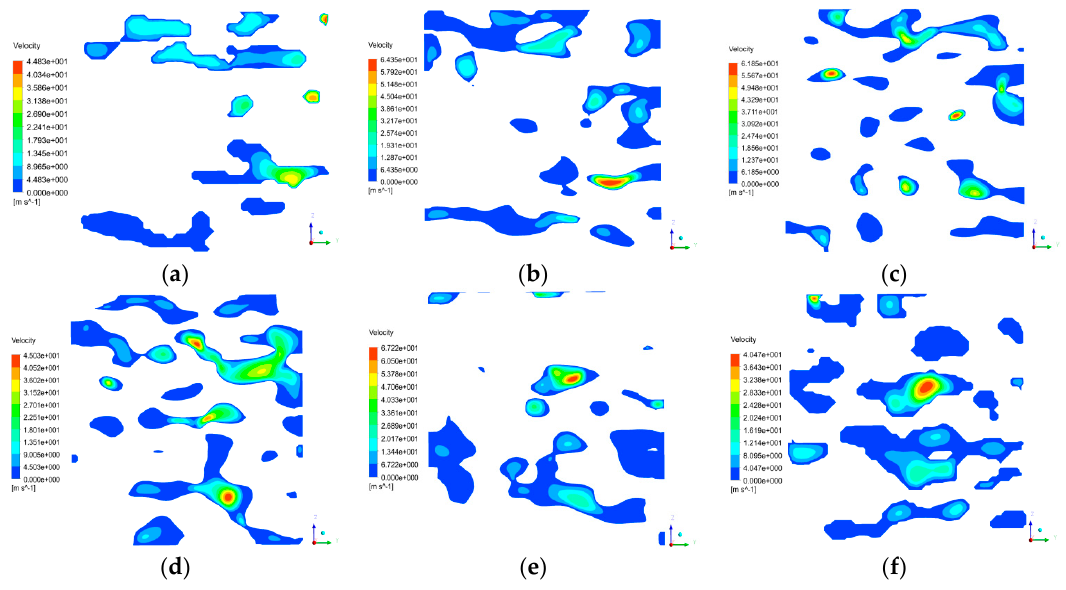
Figure 12. Water seepage velocity distribution of different sections of the single channel in the X direction: ( a ) x = 0 μ m; ( b ) x = 12 μ m; ( c ) x = 24 μ m; ( d ) x = 36 μ m; ( e ) x = 48 μ m; and ( f ) x = 60 μ m.